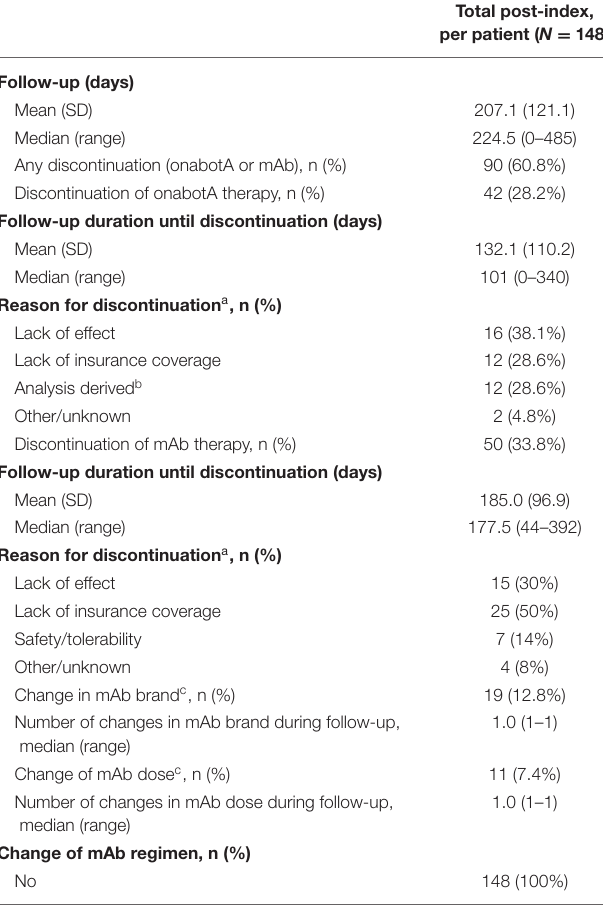
TABLE 6 | Combination treatment changes and discontinuation during